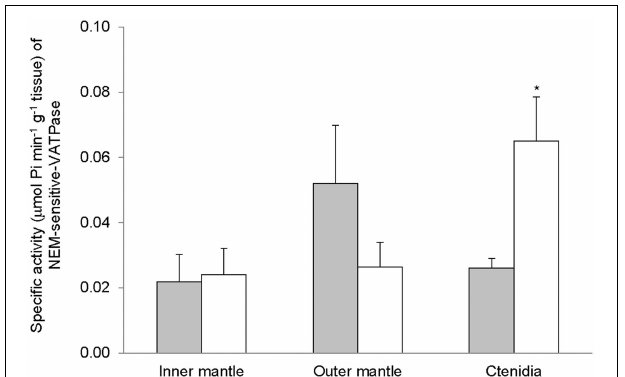
FIGURE 6 | Mass-specific activity ( µ mol Pi min − 1 g − 1 tissue) of N-ethylmaleimide (NEM)-sensitive V-type H + -ATPase (VATPase) from the inner mantle, the outer mantle, and ctenidia of Tridacna squamosa exposed to 12h of darkness (control; closed bar) or 12h of light (open bar). Values represent means + S.E.M. ( N = 4 ). ∗ Significantly different from the control ( P < 0 . 05 ).